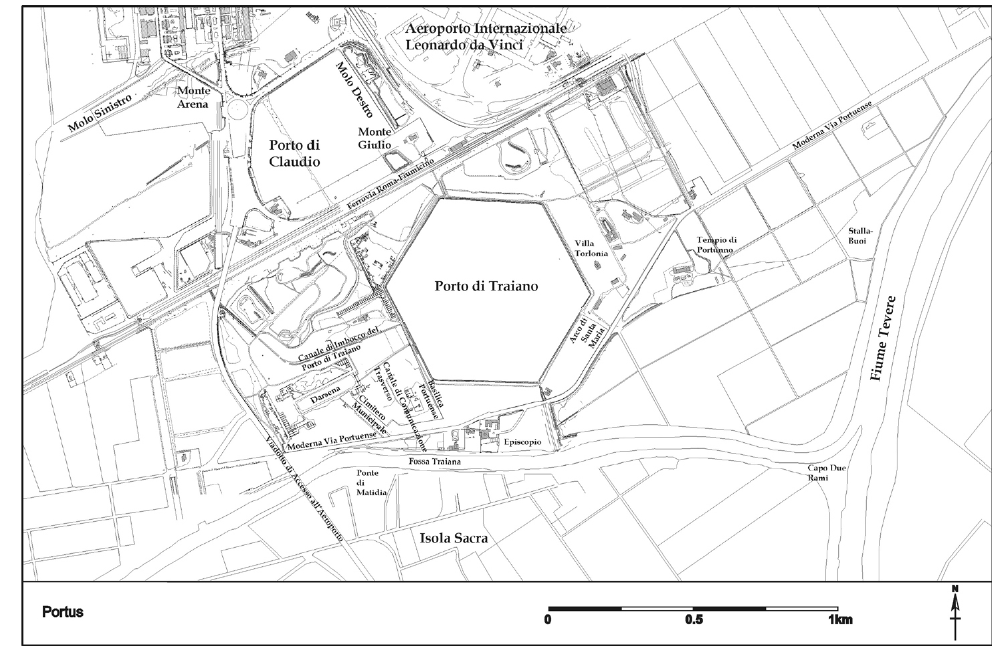
Figure 18. Trajan ’ s Port at Ostia [30]. Figure 18. Trajan’s Port at Ostia